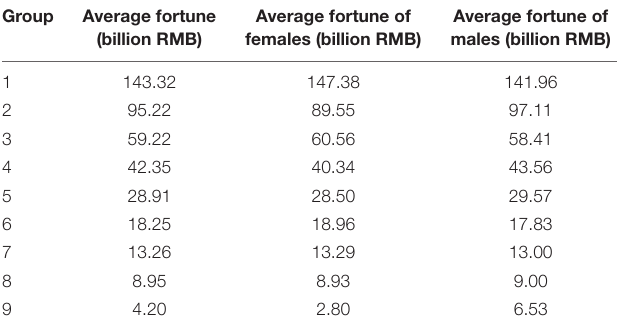
TABLE 2 | Average fortune of each group of targets in Study